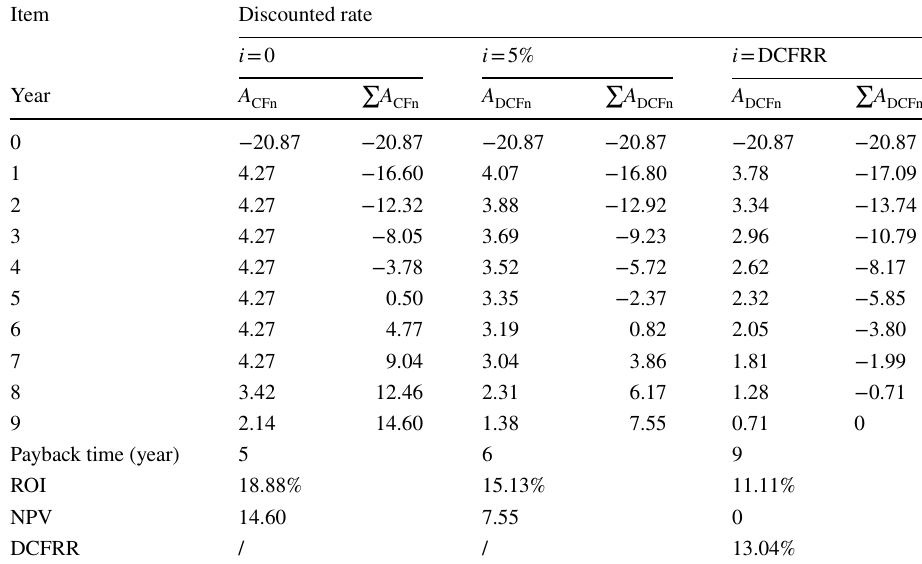
Table 5 Predicted annual cash flow and economic indicators for different discounted interest rates